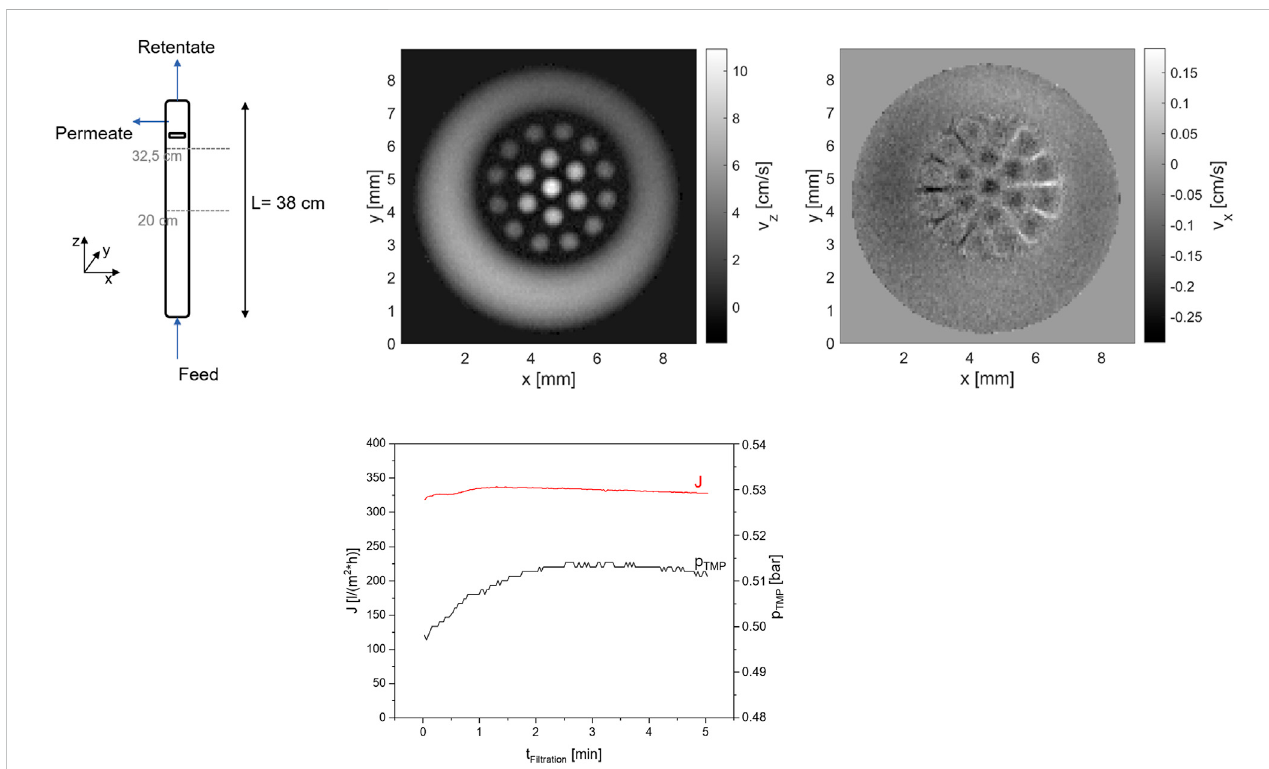
Topleft:PositionsofMRImeasurementsalongthe fi ltrationmodule.Position z =32.5 cmislocatednearthepermeateoutlet, z =20 cmroughlyisinthe middle of the used membrane. While p TMP = .5 bar, the velocity along z , v z , shows the expected laminar pro fi le in the channels (pure water). The value of v z obviously depends on the radial position of the channel in the xy plane: v z is much larger in the center channel of the membrane than in the outer channels. Compared to v z , the in-plane velocities, here the example of v x , are orders of magnitude smaller as expected. Nevertheless, channeling of the permeate in the fi ber can be observed similar to the fi ndings in (Schuhmann et al., 2019). Please also note that the direction of fl ow is radial, which leads to positive and negative values of v x . Bottom: Parallel to the MRI measurements, the established fi ltration parameters were recorded as a function of fi ltration time for